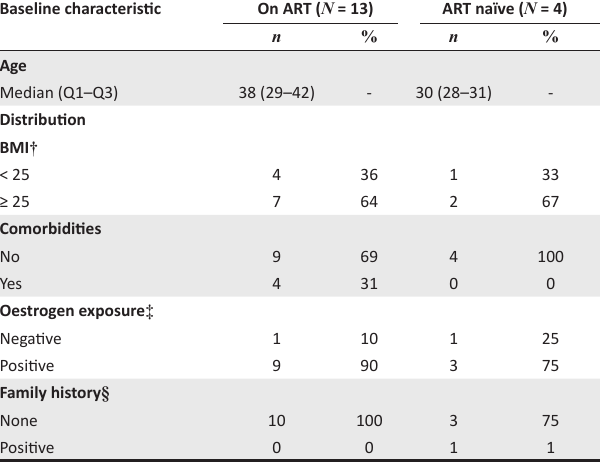
TABLE 2: Demographics and clinical parameters of women living with HIV with